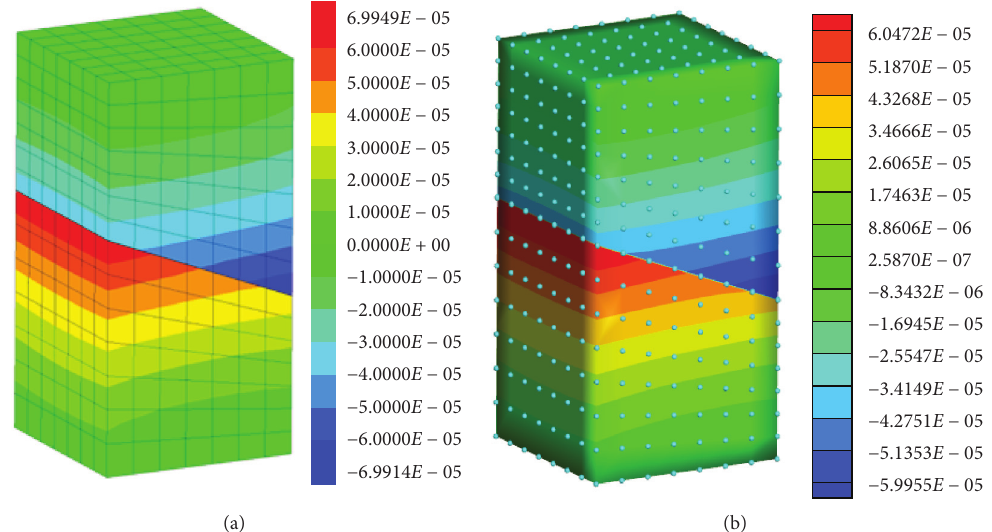
Figure 8: Horizontal displacement nephogram (m). (a) FLAC 3D . (b) LRPIM.